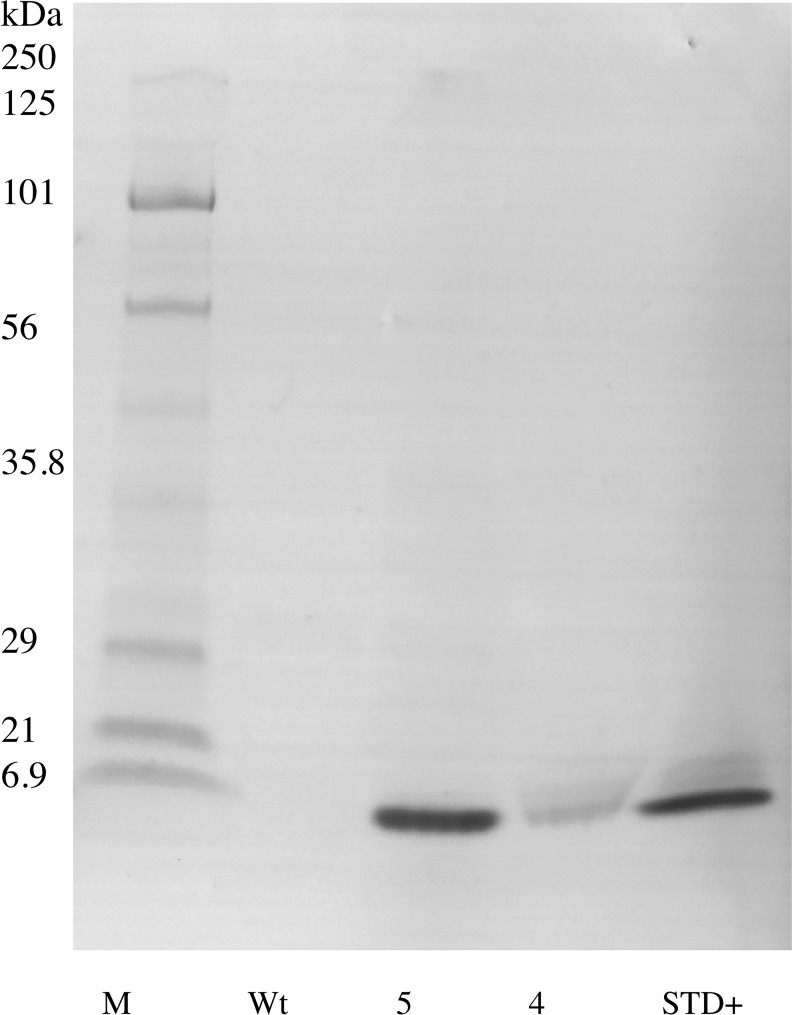
Immunoblot of enriched small molecular weight soluble protein extracted from dry transgenic ShEGF soybean seeds.Protein extracts from two independent homozygous lines (5 and 4) are compared to both nontransgenic (Wt) and commercially available EGF standard (STD +). EGF was detected using an EGF specific antibody and indirect secondary antibody coupled to alkaline phosphatase. M marker; kDa kilodalton.